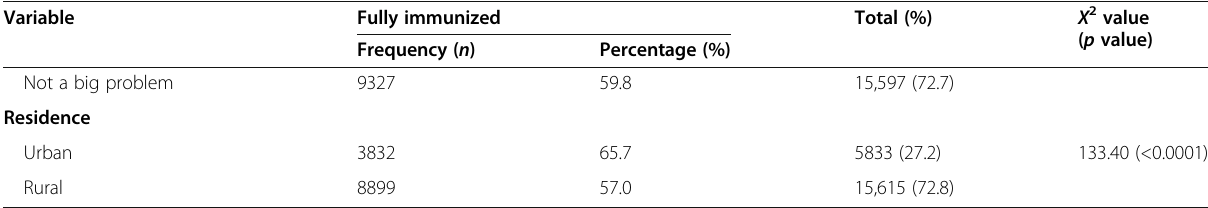
Table 2 Socio-demographic, economic, maternal, and obstetric characteristic respondents in the 12 sub-Saharan African countries (Continued) Variable Fully